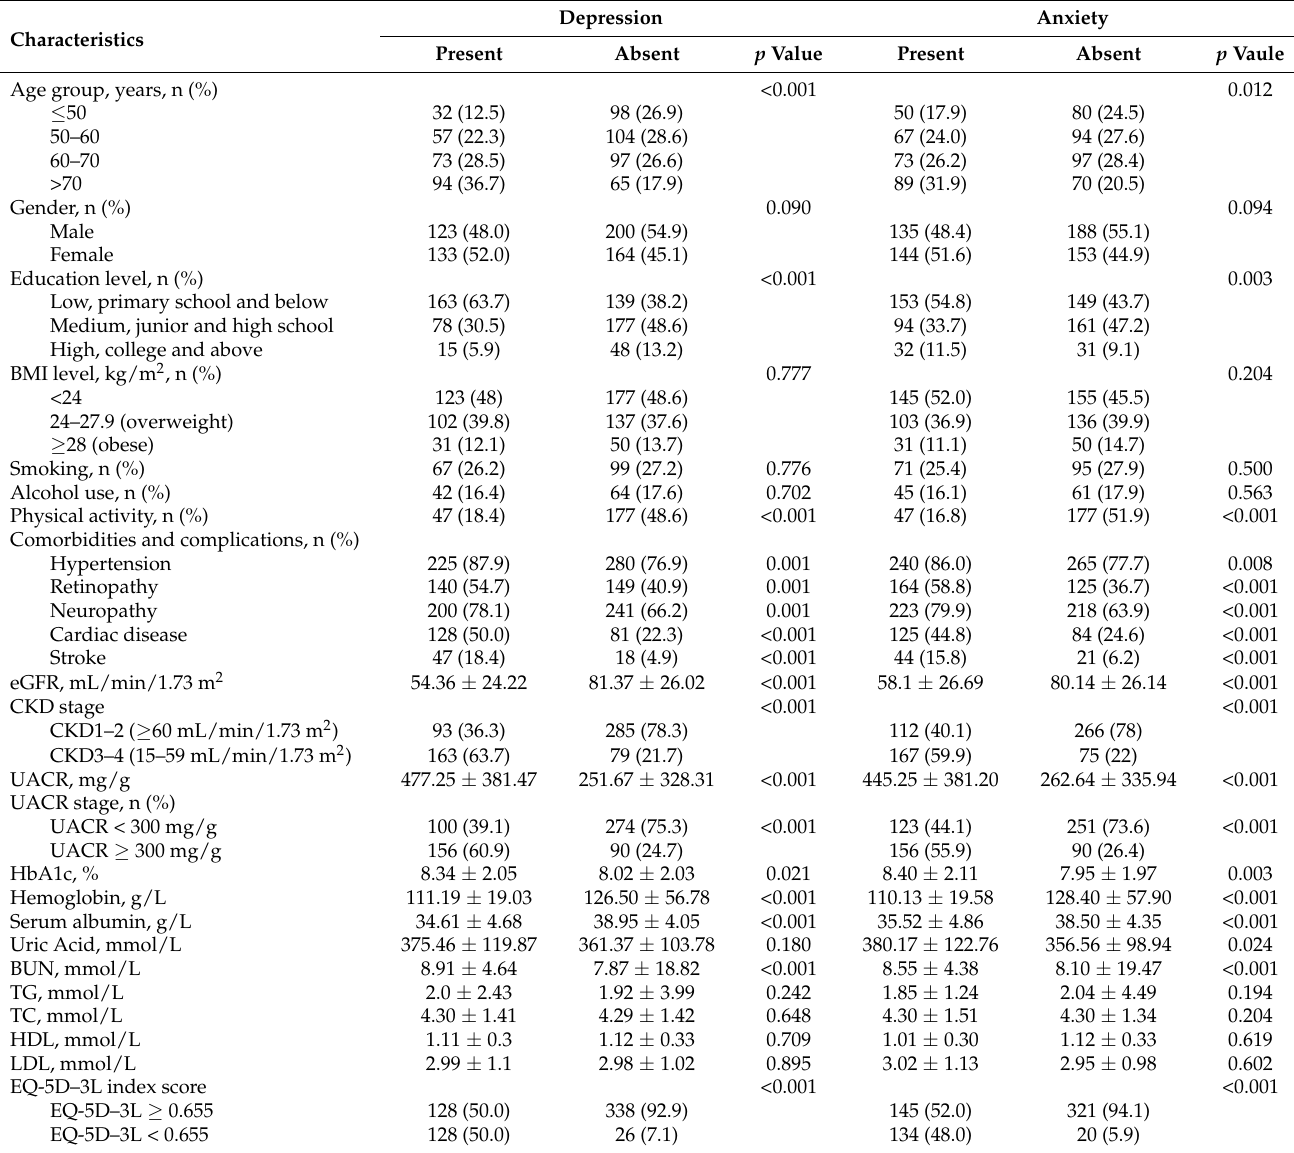
Table 3. Socio–demographic and clinical factors associated with depression and anxiety in the DKD